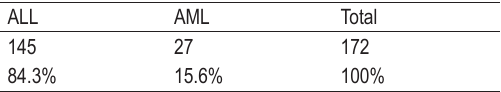
TABLE 1. ALL and AML sick children